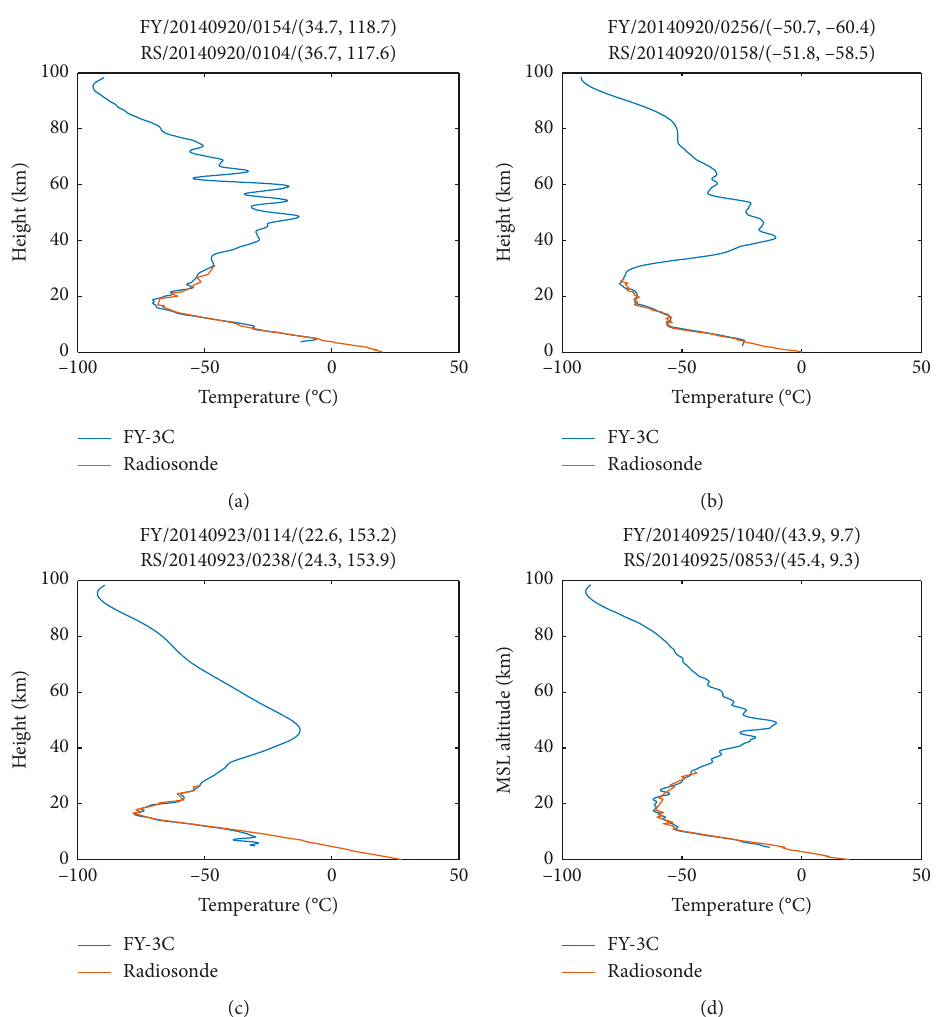
Figure 9: Comparison of the temperature profiles obtained from FY-3C GPS radio occultation data and radiosonde